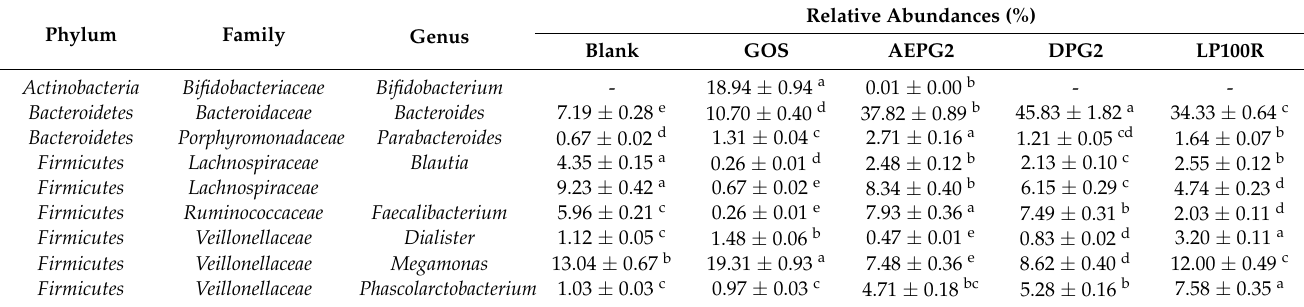
Table 3. Relative abundances of 9 microbes in different groups at the genus